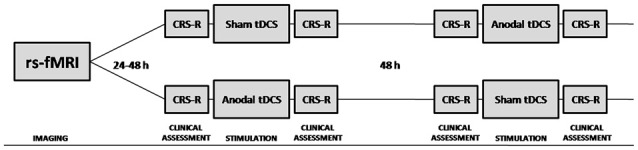
Schematic representation of the study protocol. Resting state functional magnetic resonance imaging (rs-fMRI) was performed 24–48 h prior to inclusion in the double-blind randomized cross-over transcranial direct current stimulation (tDCS) trial. Behavioral signs of consciousness were assessed by means of standardized Coma Recovery Scale Revised (CRS-R) assessments, performed before and directly after the anodal tDCS and sham tDCS sessions.